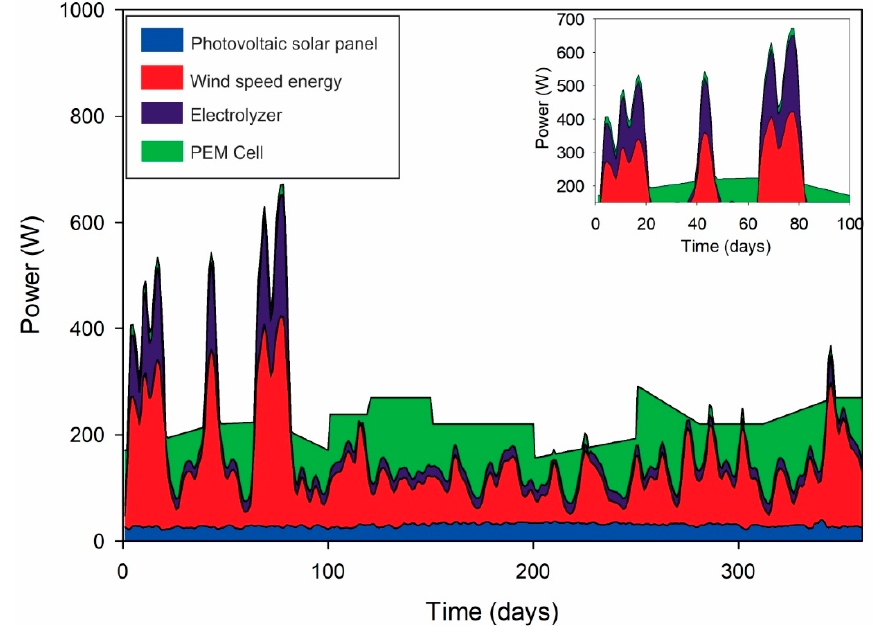
Figure A4. Power for Bremen.